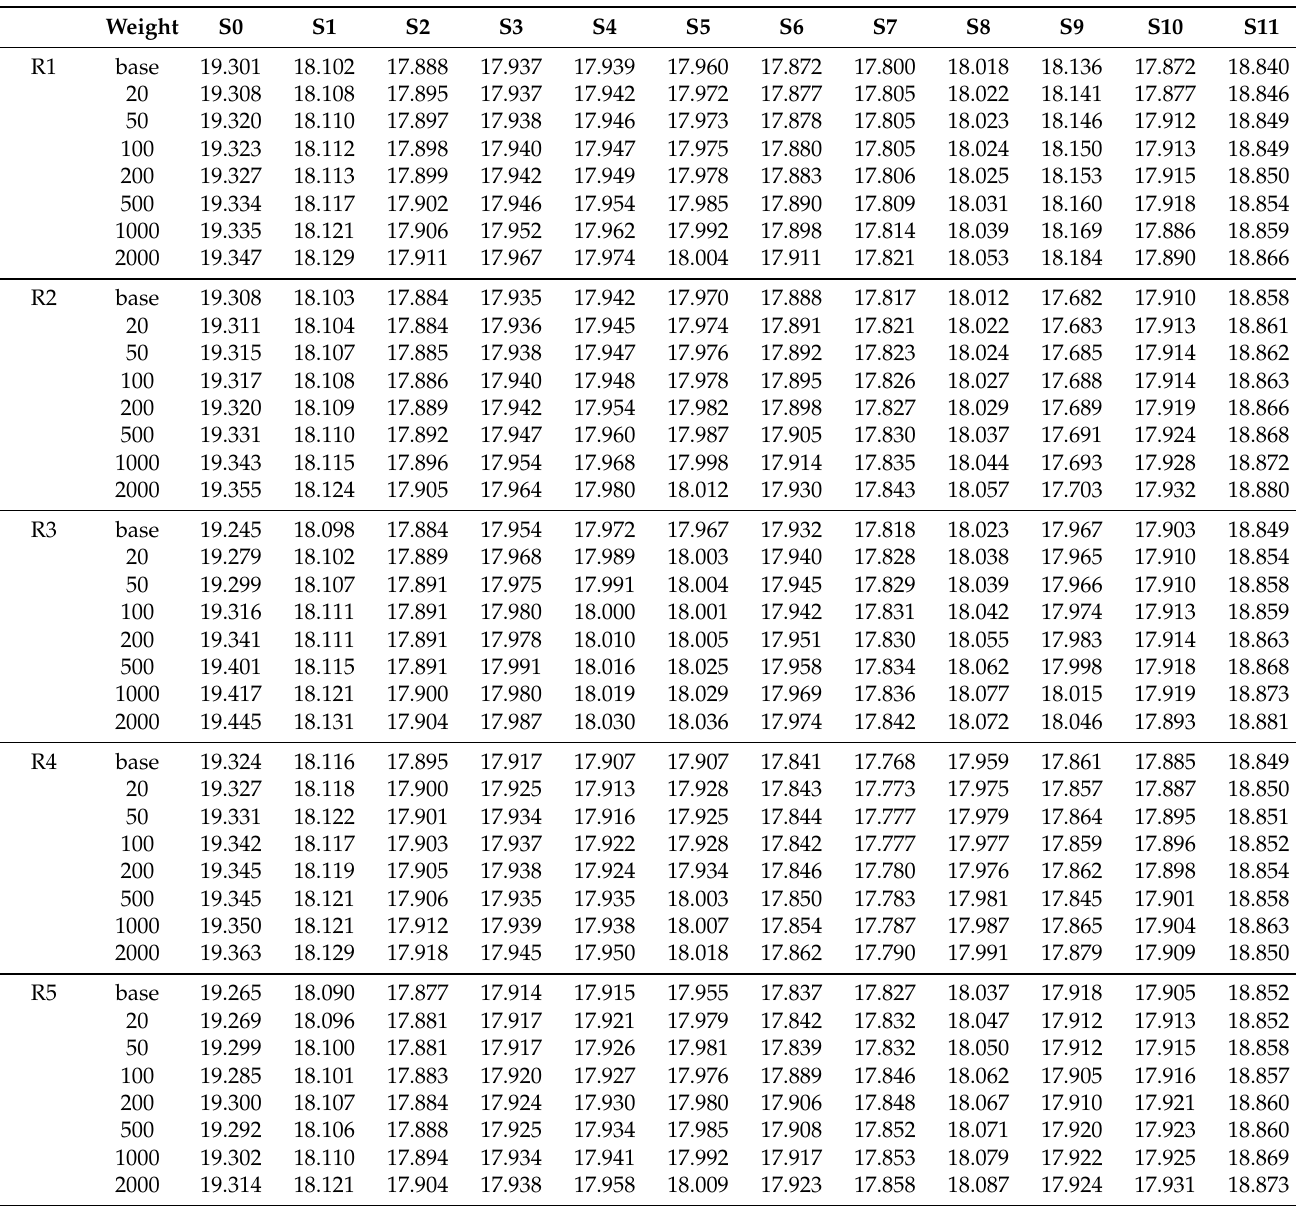
Table 3. Plantar insole—foot size 38 (24